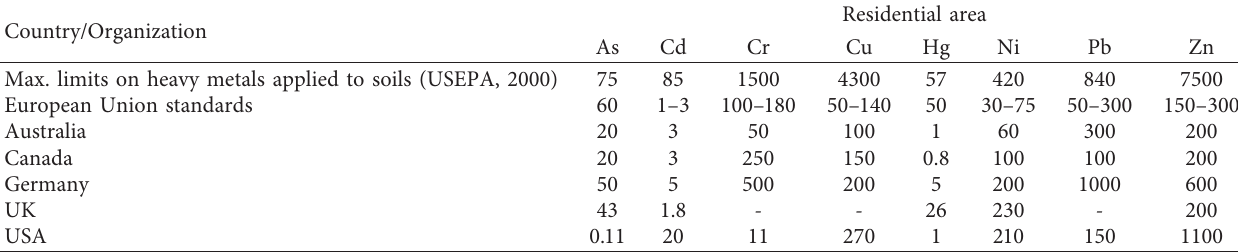
Table 1: The basic properties of the four heavy metals [32, 33,